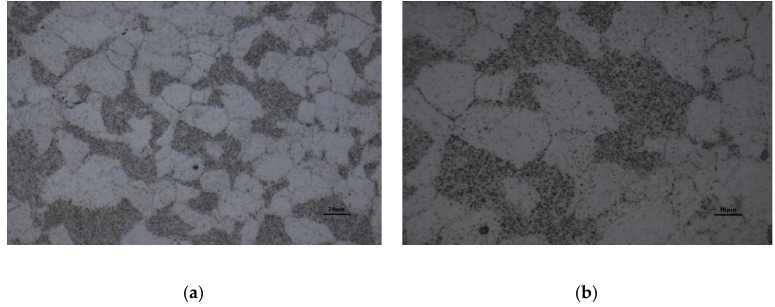
Figure 5. Metallographic structure of inner surface in the 0 ◦ direction. ( a ) 500 × , ( b ) 1000 × .